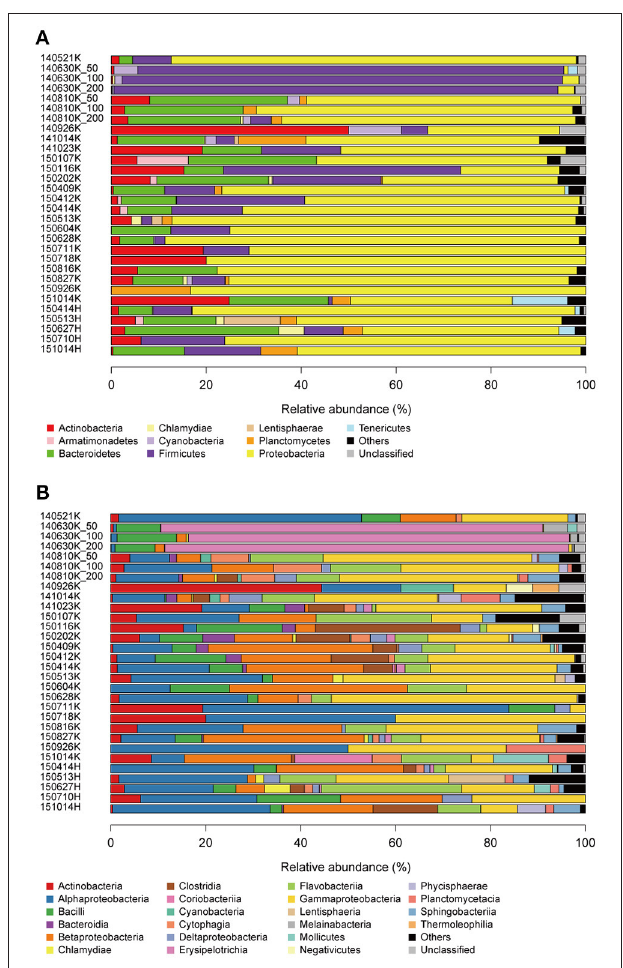
FIGURE 3 | Relative abundances of sequences at the phylum (A) and class (B) levels. Groups demonstrating < 5% abundance were summarized as